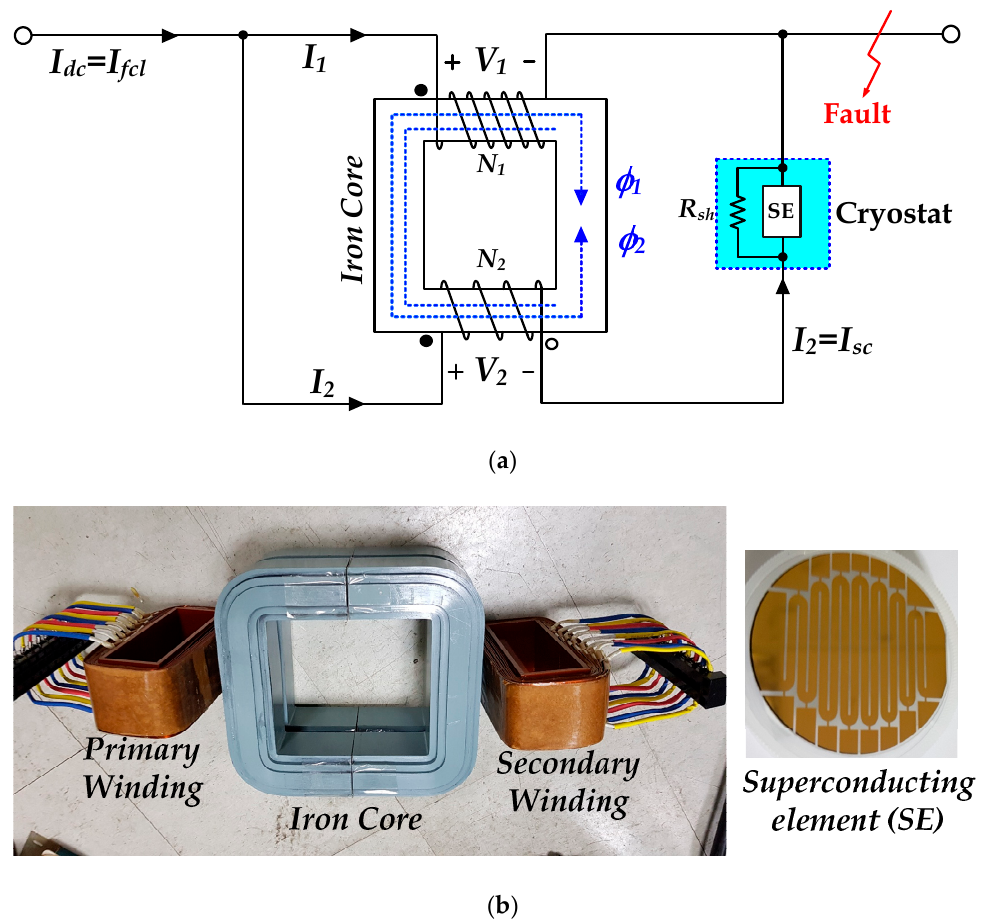
Figure 2. Structure of the SFCL with two parallel flux-coupled coils: ( a ) schematic configuration; ( b ) iron core, windings, and SE used for the test prototype.